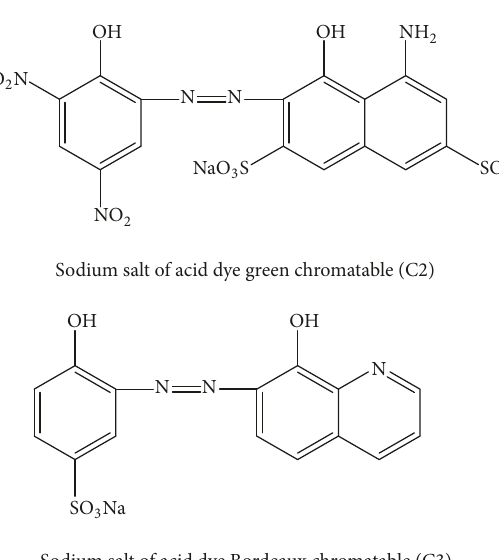
Figure 1: The structures of the acid dyes chromatables